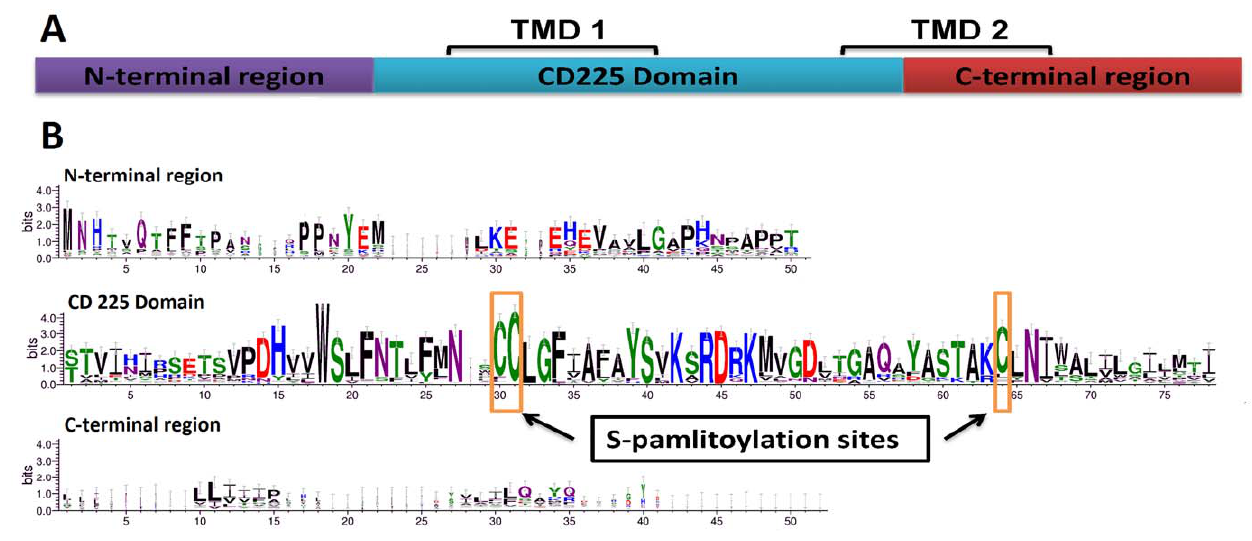
Figure 1. Domain analysis and sequence characteristics of IFITM gene family. Sequence logos were generated based on the alignment of all IFITM and IFITM-like genes identified (160 sequences) in this study. ( A ) Gene structure of all IFITM and IFITM-like genes. ( B ) Logos of the C-terminal region, CD225 domain and N-terminal region.